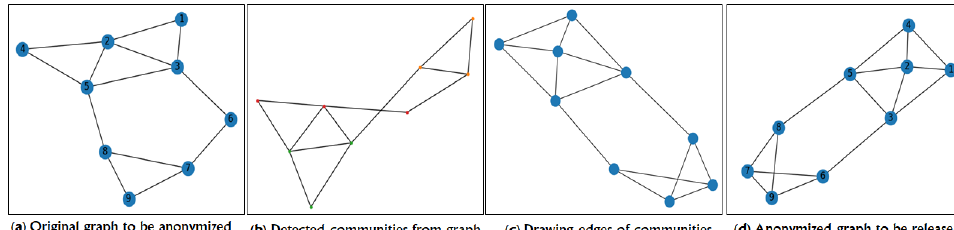
Figure 23. Overview of G anonymization using community detection